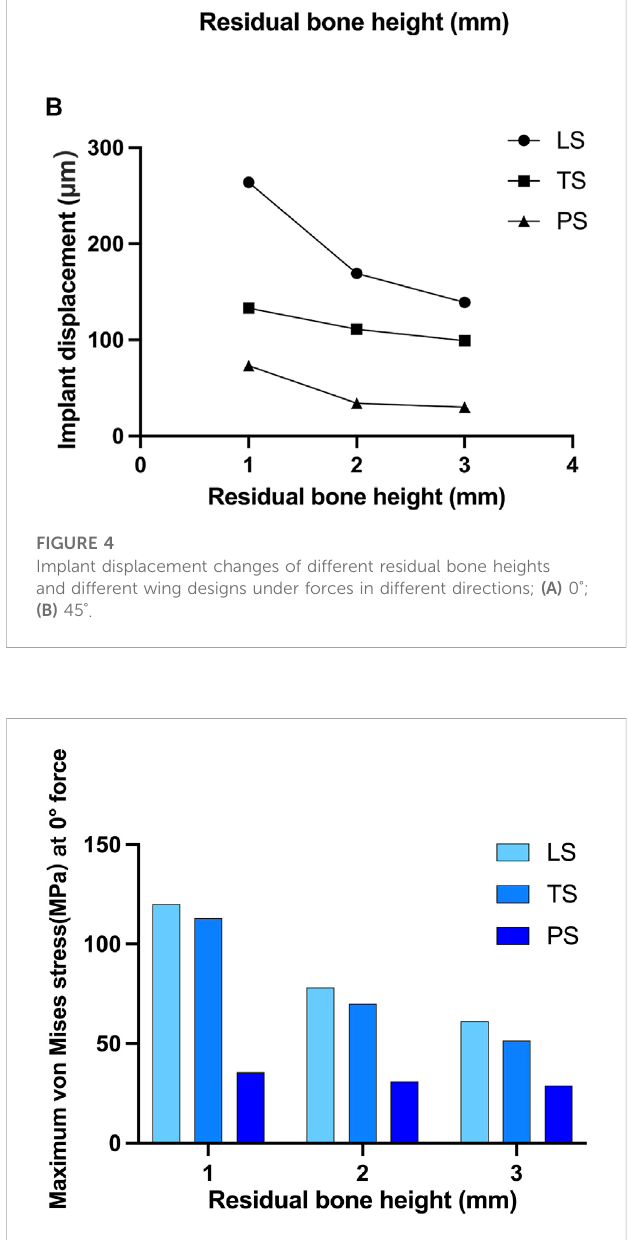
Maximum von Mises stress on crestal cortical bone of different residual bone heights and different wing designs at 0 °